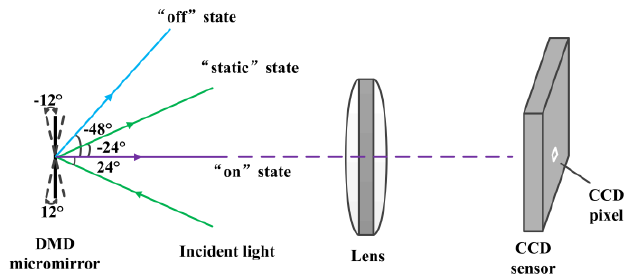
Figure 1. The direction of DMD mirrors.